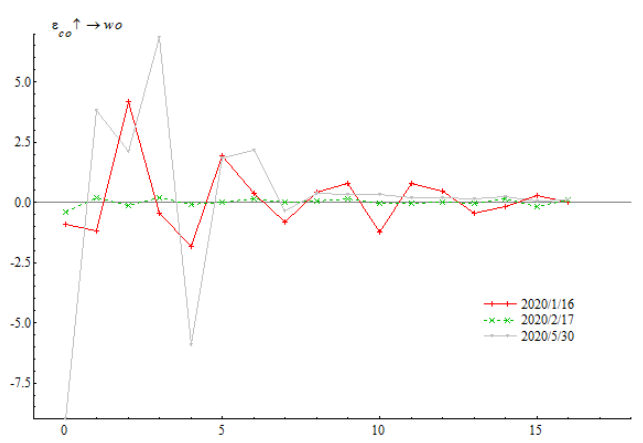
Figure 8. Impulse responses at different points for the set COVID-19 and log prices. Note: The abscissa refers to the number of lag periods of the impact, and the ordinate indicates the impulse response values after the shock of one-unit standard deviation.